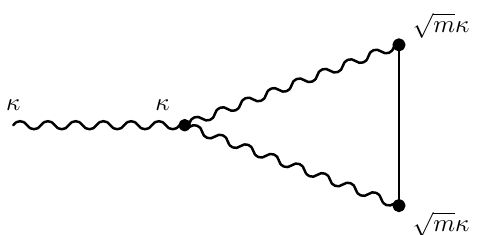
Figure 2. The wordline loop contribution to hH µν ( x ) i , where a straight line denotes the propagator for the perturbed worldline. With the proper factors of κ shown in the diagram, we again obtain a quantum correction proportional to mκ 4 ∝ G 2 m to the gravitational N